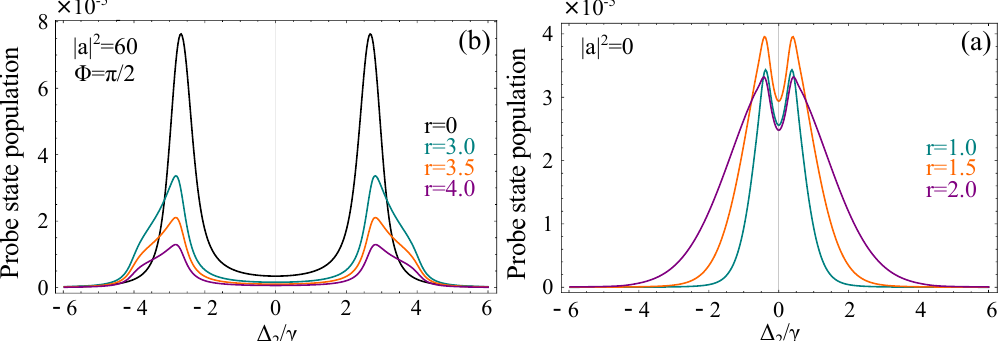
Figure 5. ( a ) Population of the probe state | b (cid:105) as a function of ∆ 2 for different degrees of extreme squeezing, Φ = π /2 and | a | 2 = 60. Black line: r = 0, teal line: r = 3, orange line: r = 3.5, and purple line: r = 4. In both panels, T = 30 γ − 1 , g 1 = 0.7 γ , and ∆ 1 = 0. ( b ) Population of the probe state | b (cid:105) as a function of ∆ 2 for different degrees of squeezing and | a | 2 = 0, corresponding to a squeezed vacuum state. Teal line: r = 1, orange line: r = 1.5, and purple line: r =